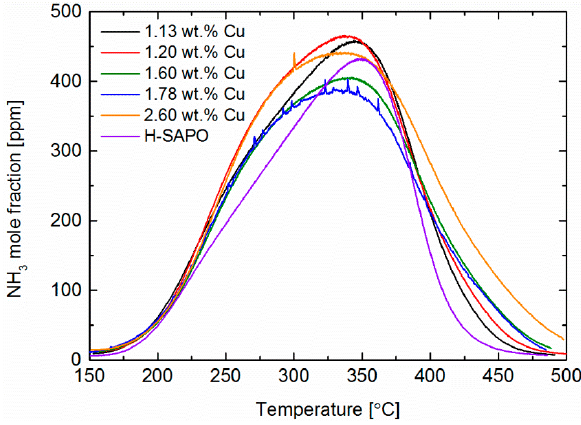
Figure 3. Temperature-programmed deorption (TPD) at 10 °C/min after storage of 400 ppm NH 3 at 150 °C and purge at 150 °C.